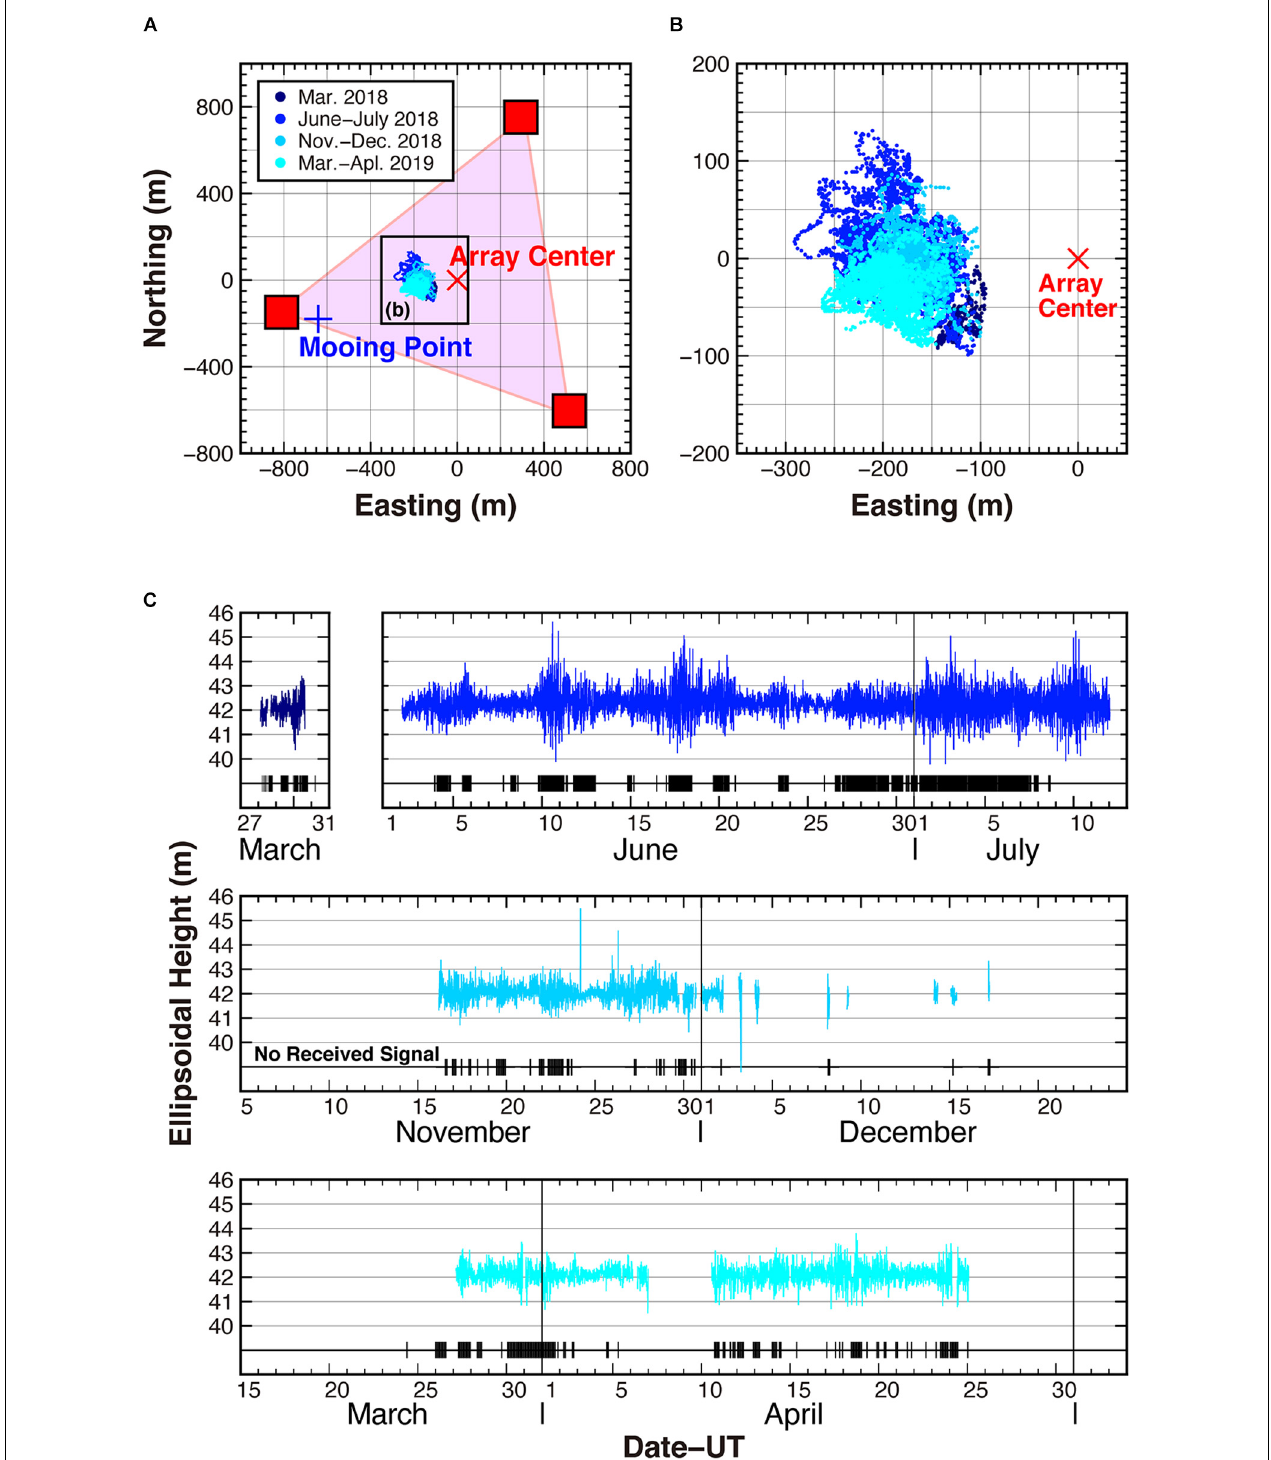
FIGURE 5 | Positions of the buoy-mounted GNSS antenna during the operational test period determined by post-processed PPP (until July) and PPP-AR (after November). (A) and (B) Horizontal positions (small dots). Different colors indicate differences in period shown by the legend in (A) . Red squares, red cross, and blue plus indicate the positions of ocean bottom acoustic transponders, center of the triangular transponder array, and anchored point of the buoy, respectively. (C) Ellipsoidal height after the tidal correction on the basis of NAO.99b model (Matsumoto et al., 2000). Black ticks indicate timings of no acoustic signal is recorded at the buoy-mounted acoustic ranging